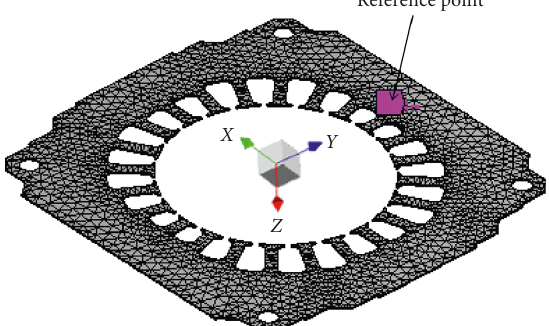
Figure 9: Numerical model of the laminated disk and reference point specification.